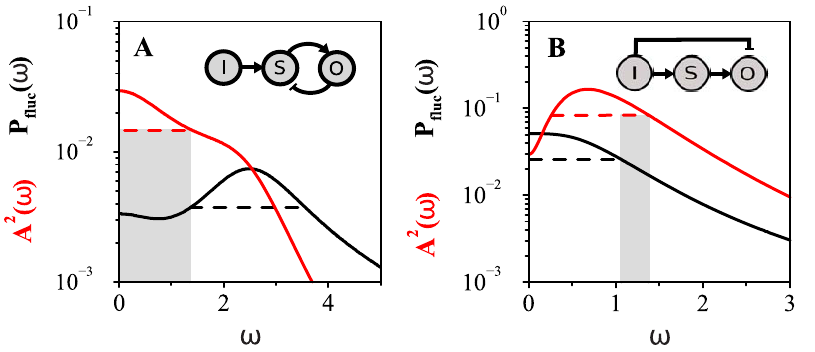
Figure 6. Noise frequency filters. Noise tolerance by filtering in frequency detection. A. Negative feedback module with FS ~ 6 and susceptibility s O ~ 0 : 34 . Red solid line: Amplitude of oscillatory output as a function of input frequency, A 2 ( v ) . Red dashed line: Bandwidth of A 2 ( v ) . Black solid line: Power spectrum of fluctuations, P fluc ( v ) . Black dashed line: Bandwidth of P fluc ( v ) . The grey region marks the noise-free frequency regime for the oscillatory response. In this case all the fluctuations are shifted to higher frequencies and do not overlap with the input frequencies detected by the module. B. Incoherent FFL with RS ~ 6 and s O ~ 0 : 34 . Lines are as in panel A. The grey region (noise-free frequency detection) is in this case only at high input frequencies.